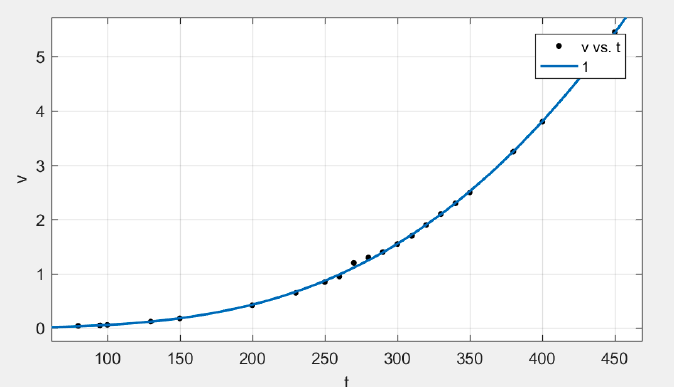
Figure 4. Curve fitting of temperature voltage response model.